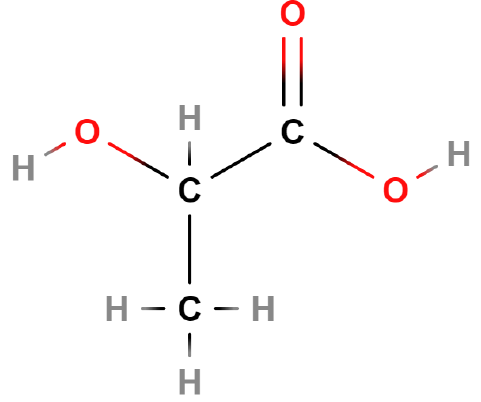
Figure 3. Structure of Lactic Acid (C 3 H 6 O 3 ). Table 2. Lactic acid’s concentration, yield, and productivity from some of the most common lignocel- lulosic